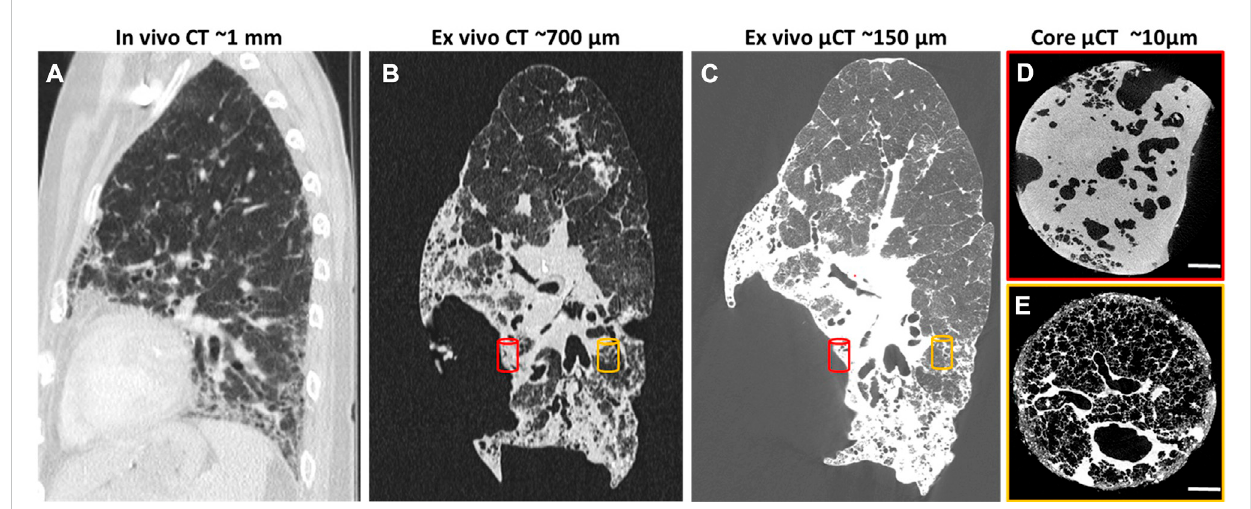
FIGURE 3 HRCT scans of human lung with usual interstitial pneumonia (UIP)[reprinted with permission from Tielemans et al. (2020)] (A) In vivo HRCT scan of thelungwithresolutionof1 mm6monthsbeforelungtransplantation; (B) Exvivo CTscanofthelungaftertransplantationwithresolutionof700 μ m; (C) Ex vivo µCT scan of the same lung with higher resolution, 150 μ m; (D, E) Core ex vivo µCT scan with resolution of 10 μ m, showing severe fi brosis (red cylinder) and more healthy area (orange